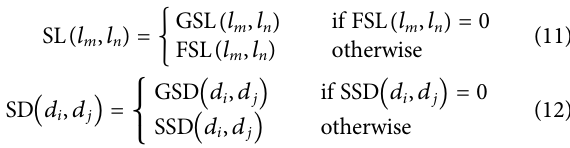
Frontiers in Cell and Developmental Biology |